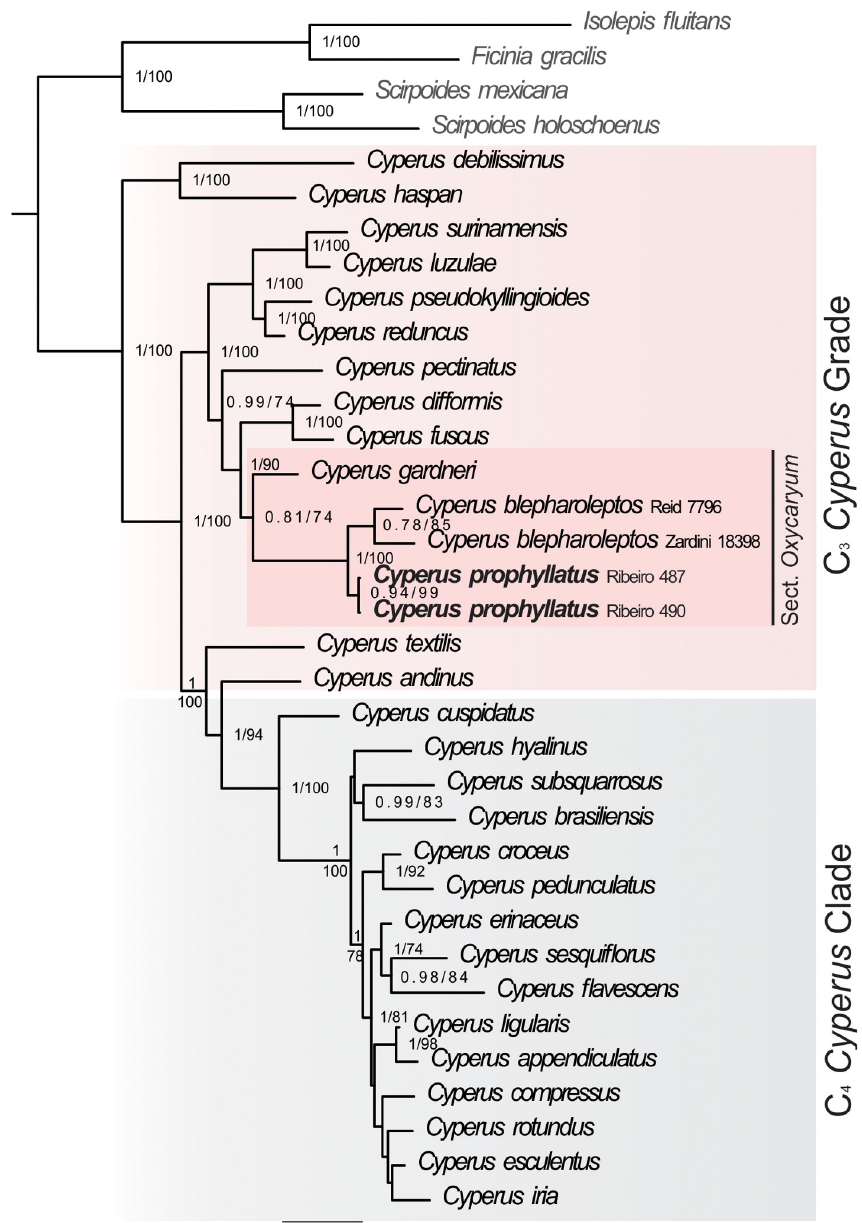
ML tree. Posterior probabilities greater than 0.75 and bootstrap values greater than 70% are shown. The newly described Cyperus prophyllatus is indicated in